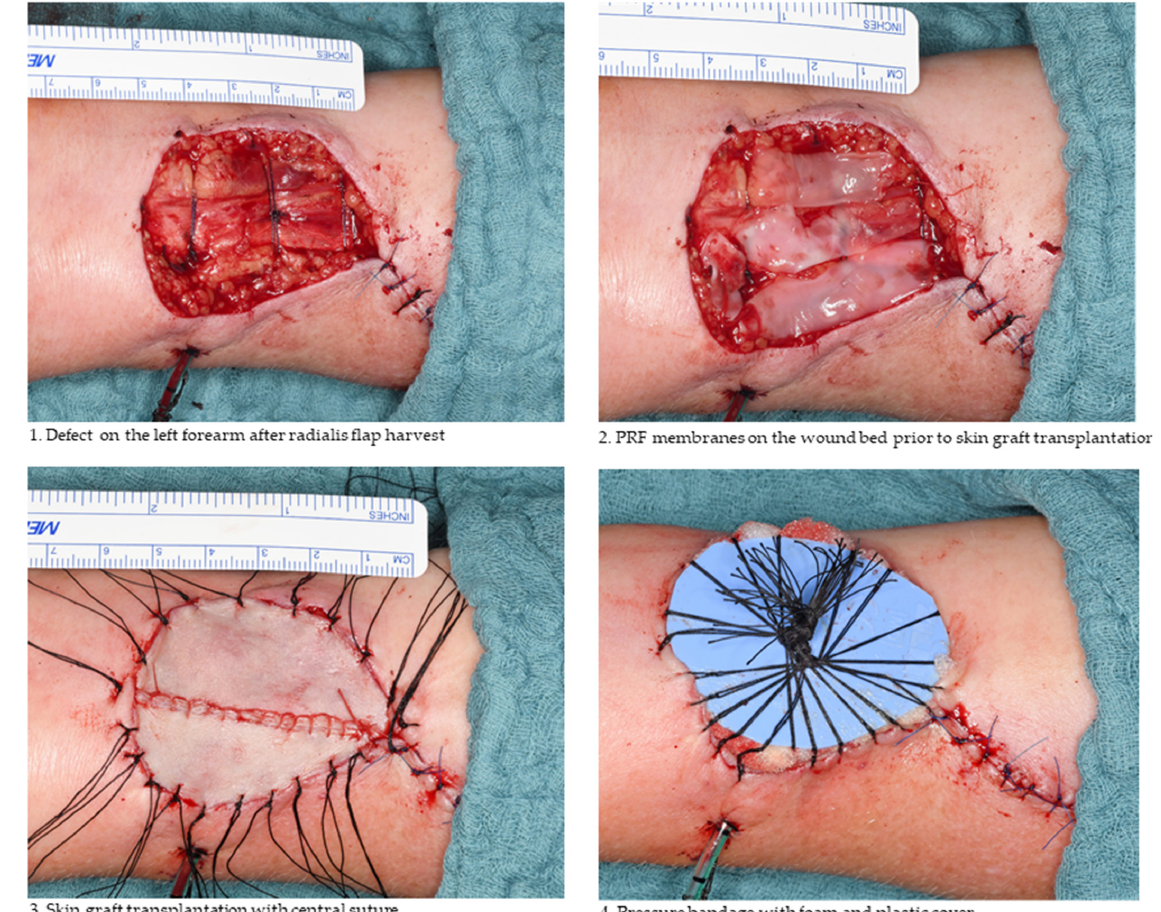
Figure 2. ( 1 ) Illustrates the defect on the forearm after radial forearm flap harvest. ( 2 ) Wound bed and tendons were covered with PRF membranes. ( 3 ) Full-thickness free skin graft from the ipsilateral arm was placed on the PRF membranes. ( 4 ) Pressure bandage was applied and followed by sterile